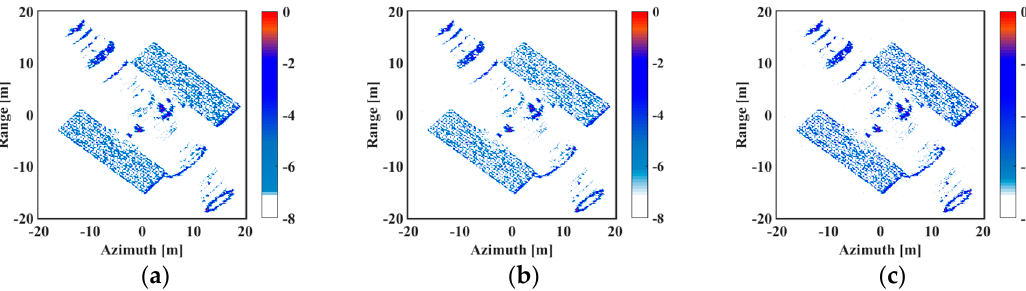
Figure 17. Imaging results obtained by l 1 -norm algorithm under di ff erent SNRs: ( a ) SNR = 10 dBs; ( b ) SNR = 5 dB; ( c ) SNR = 0 dB.